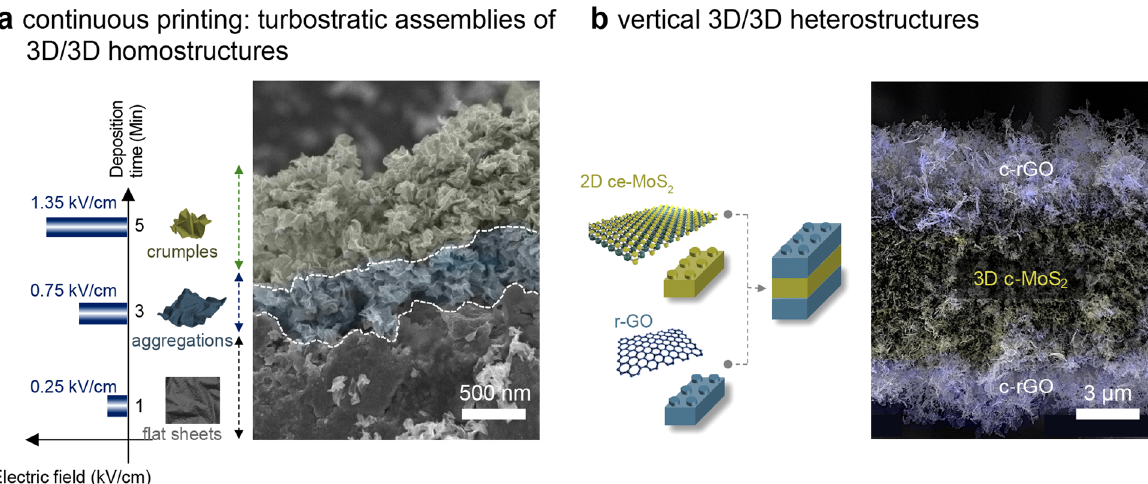
Fig. 2 Design fl exibility of E-3D printing-DROPS. a Electric- fi eld vs. deposition-time bar chart diagram demonstrates the capability of creating a single monolith made of the chemically identical compositions but characterized with structurally dissimilar morphologies in a single, continuous deposition. The critical electric fi eld and threshold deposition time of each stage are indicated. Corresponding false-colored, HRSEM image shows the three discrete morphologies, including stacks of fl at sheets in gray, heavily wrinkled aggregations in blue, and turbostratic assemblies of crumples in yellow, created through a continuous DROPS deposition coupled with increasing electric fi eld gradients. b Schematic representations feature the direct creation of vertical 3D/3D heterostructures (left). This is accomplished by implementing a dual-sourced DROPS deposition that allows for piecing together two of the most prominent 2D building blocks along the out-of-plane direction relative to the collecting substrate. Image on the right depicts the corresponding EDS mapping that shows the spatial distribution and uniform coverage of each element (carbon in purple and molybdenum in